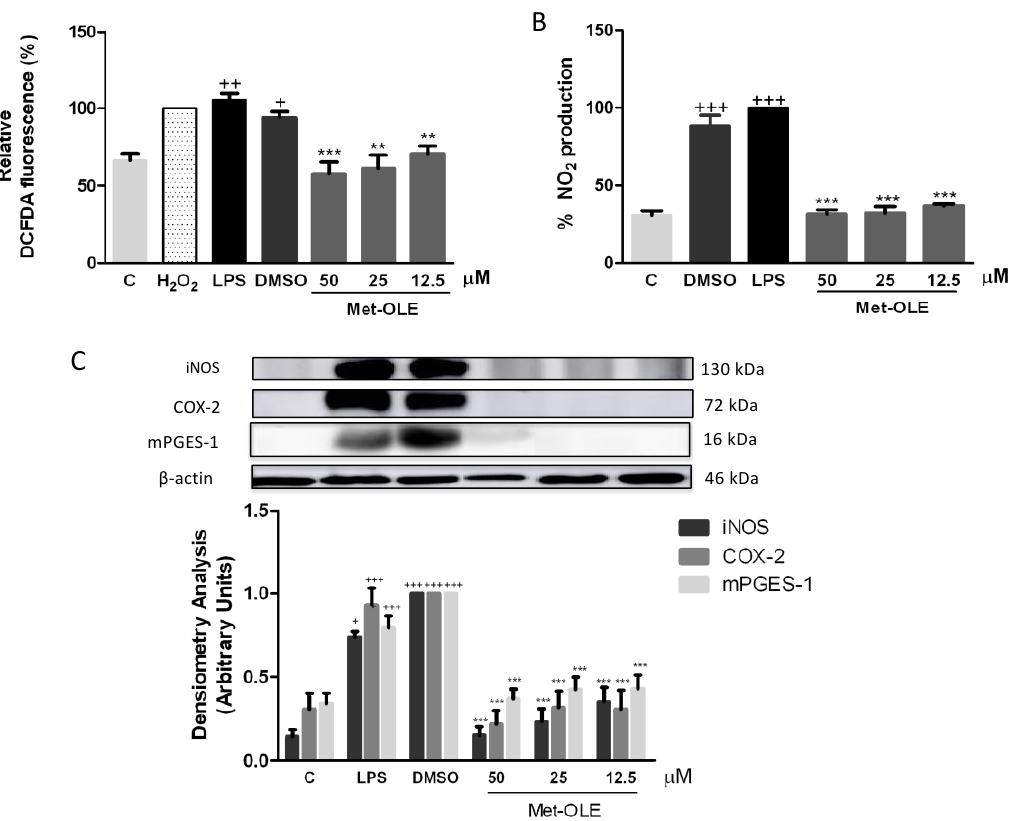
Figure 4. Effects of met-OLE on ( A ) intracellular ROS and ( B ) NO production and ( C ) overexpression of the iNOS, COX-2 and mPGES-1 proteins. Macrophages were pretreated with met-OLE (50, 25 or 12.5 µ M) for 30 min and then, LPS-stimulated during 18 h. Subsequently, ROS and NO levels were measured using DCFDA and Griess assays in supernatants, respectively. The expression of iNOS, COX-2 and mPGES-1 proteins was then measured in whole cell lysates and analyzed by Western blotting. Results are presented as mean ± SEM of at least six independent experiments. + p < 0.05; ++ p < 0.01; +++ p < 0.001 vs. unstimulated control cells; ** p < 0.01; *** p < 0.001 vs. LPS-DMSO stimulated cells.